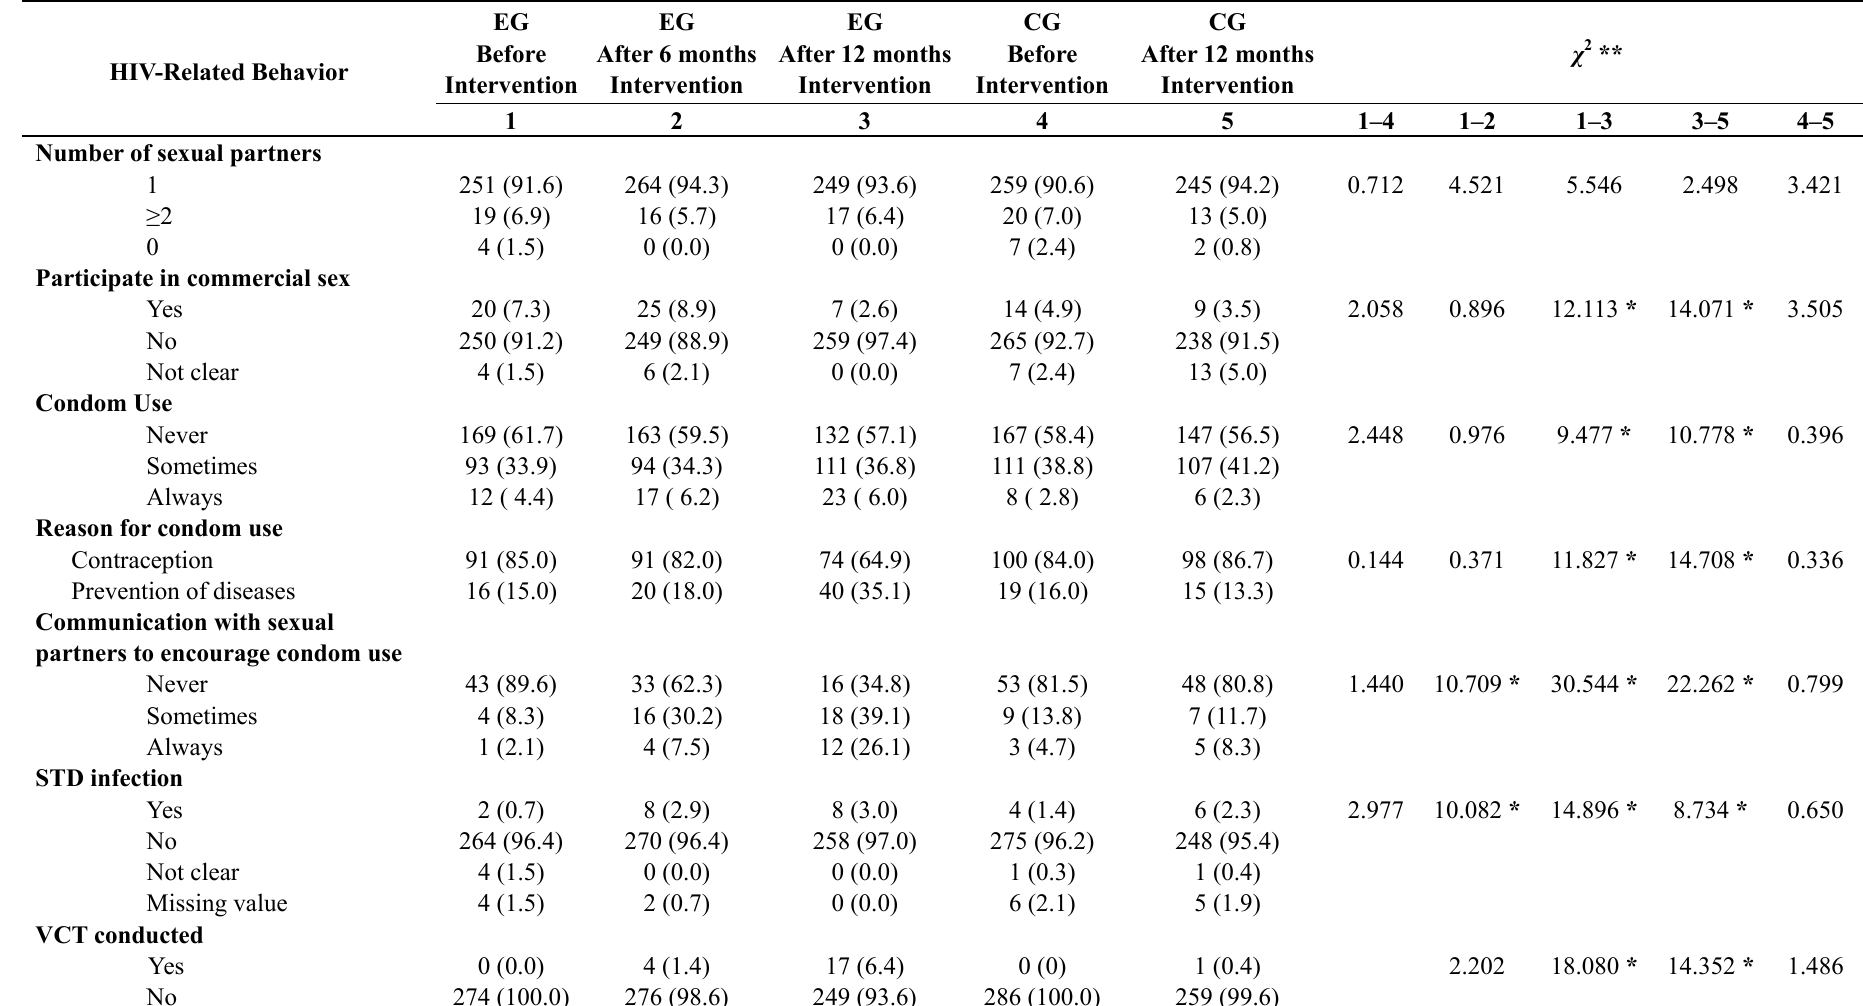
Table 4. Differences in HIV/AIDS-related